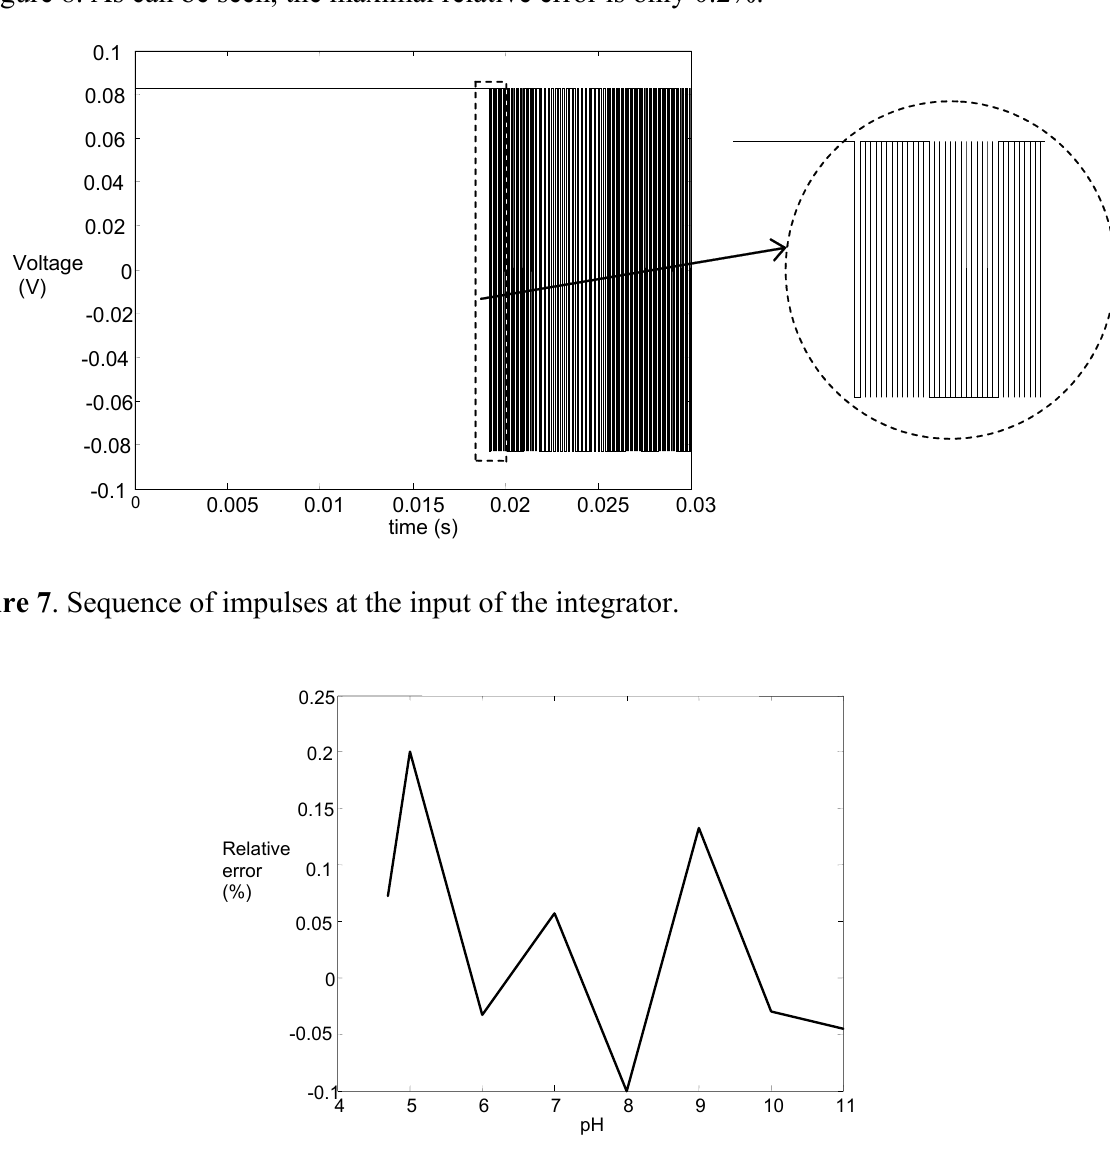
Figure 8. Relative error of measured